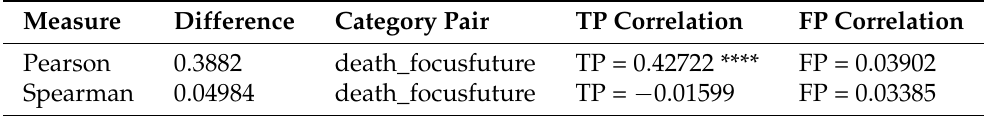
Table 16. Death and Focusfuture in High.